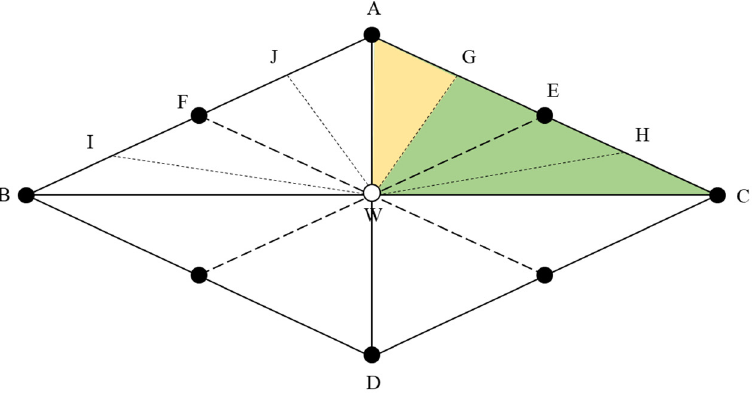
Figure 3. Diamond-shaped reverse nine-spot well pattern.